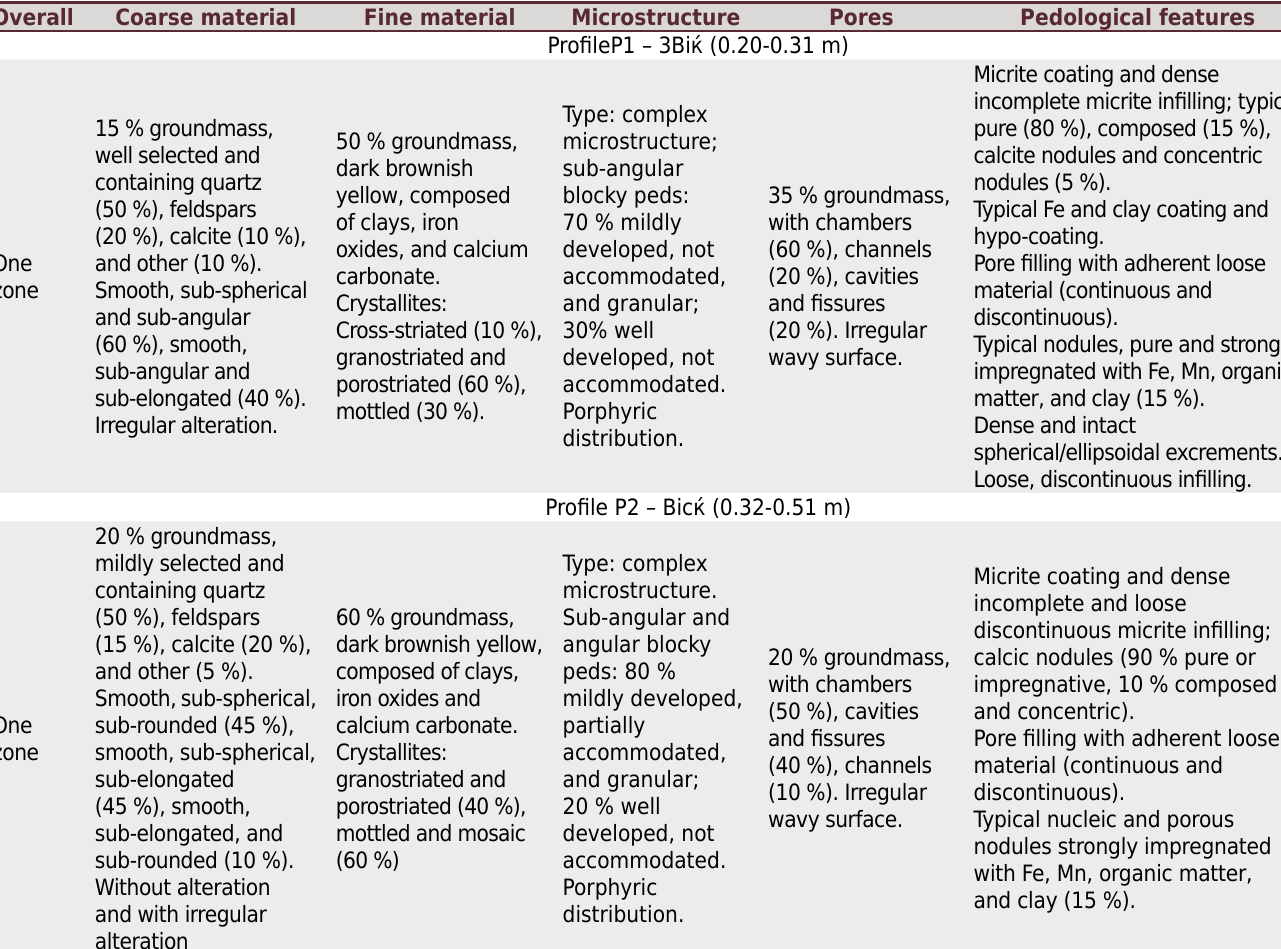
Table 4. Micromorphological description of selected horizons in soil profiles P1 and P2 from the Apodi Plateau Overall Coarse material Fine material Microstructure Pores Pedological